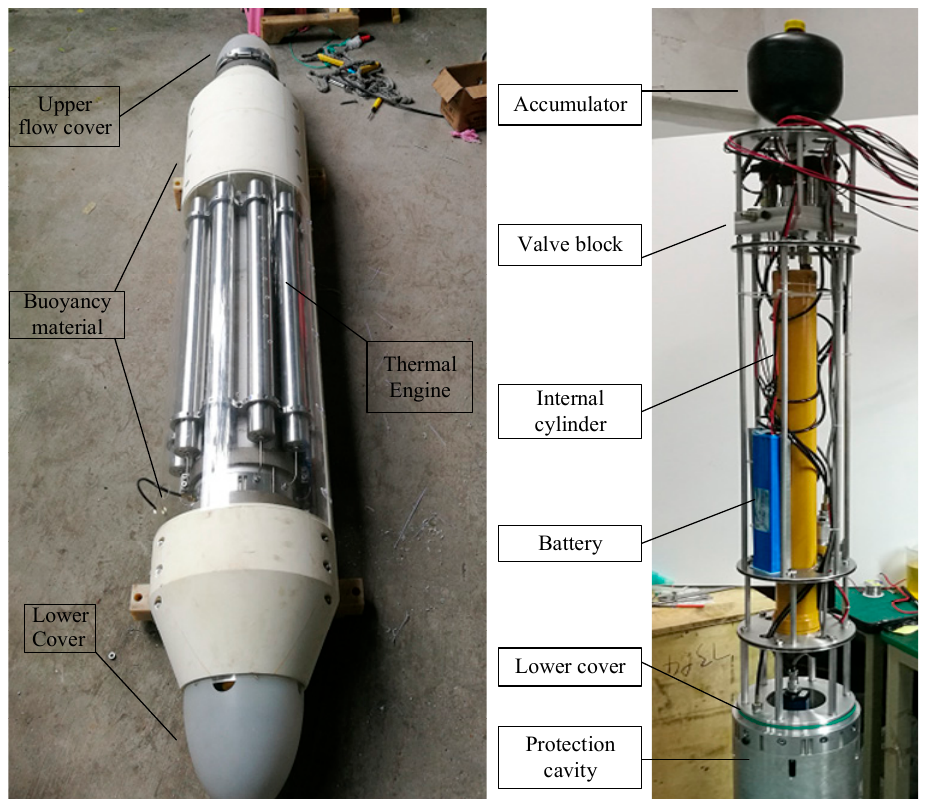
Figure 6. The profiler